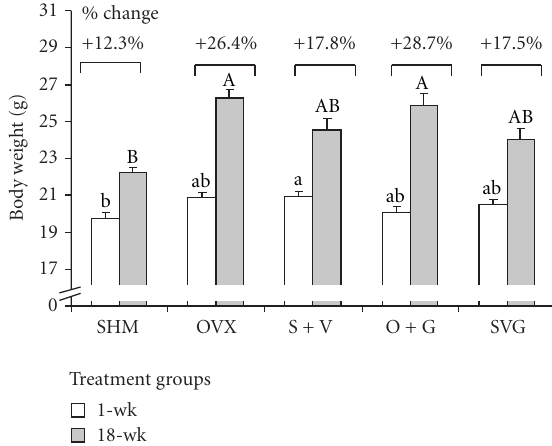
Figure 3: Mouse body weights at the beginning and end of the study. Bars represent mean ± SEM values. Di ff erent lower- and upper-case letters signify di ff erences between groups at 1-wk ( P = . 0212) and 18-wk ( P < . 0001), respectively. Percentage values correspond to the mean changes in body weight over the duration of the experiment for each of the treatment groups.